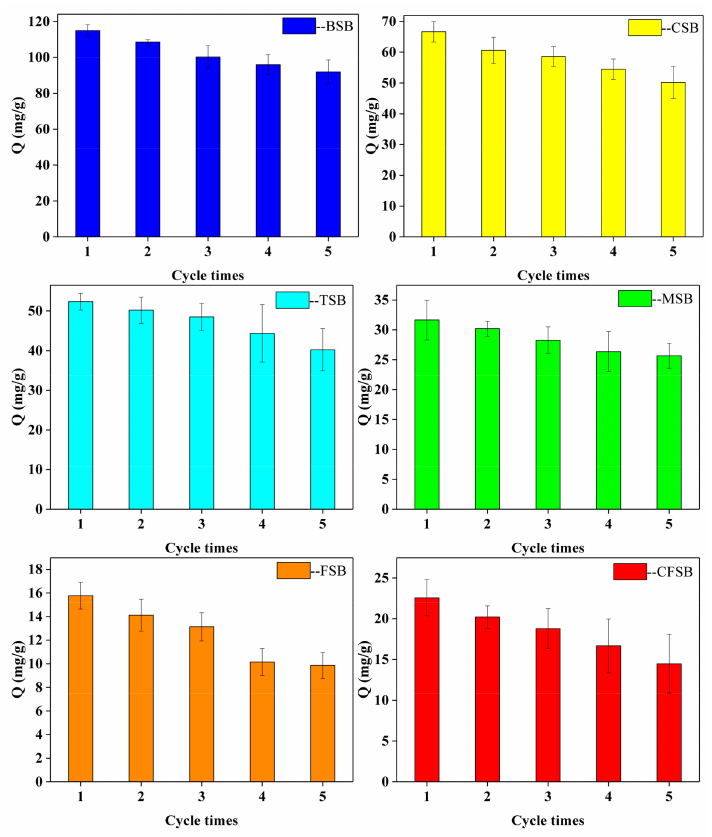
Figure 8. Recycle adsorption performance in wastewater of Cr(VI) adsorption by Mg-loaded